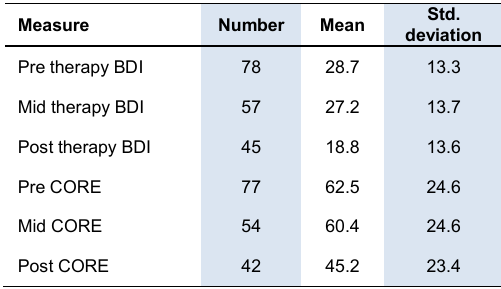
Table 3: BDI-II and CORE 34 Descriptive